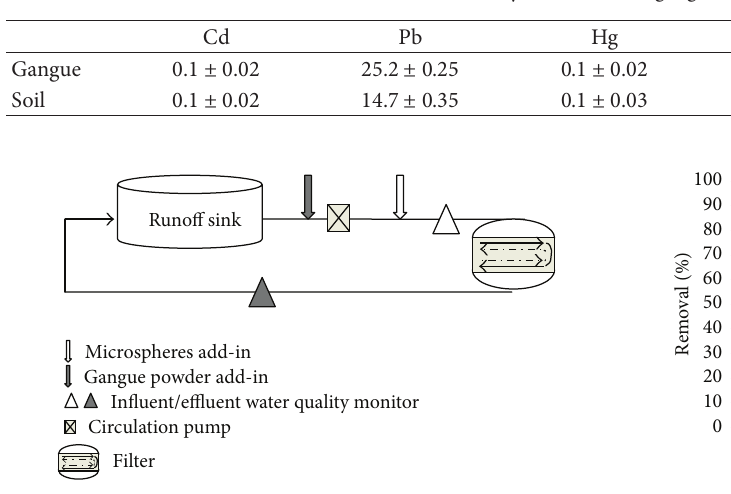
Table 2: Heavy metals in coal gangue and soil (mg/kg).